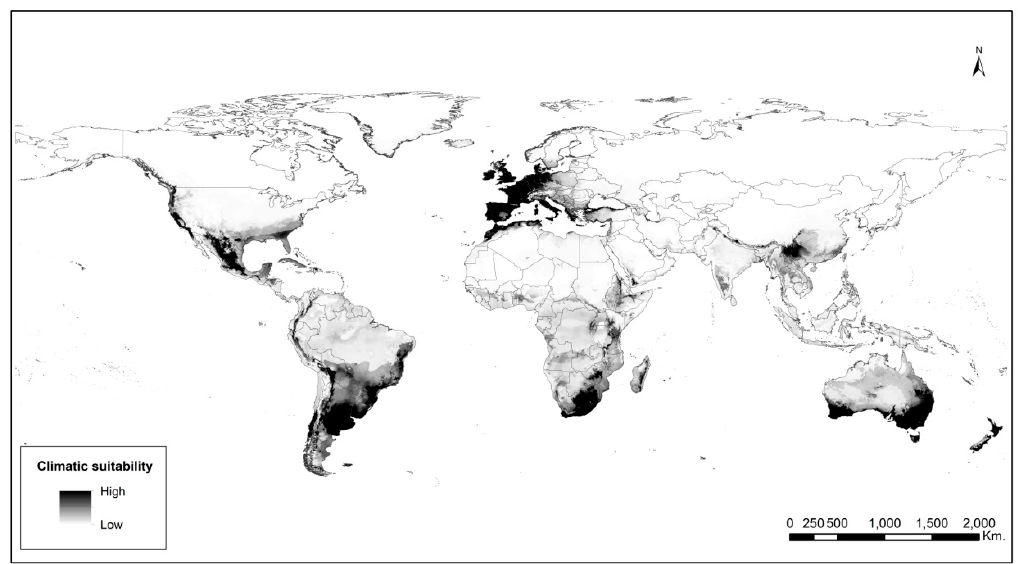
Figure 4. Current distribution and climate suitability model of Azolla filiculoides based on presence occurrences from both invaded and native ranges. Darker shades indicate higher environmental suitability.